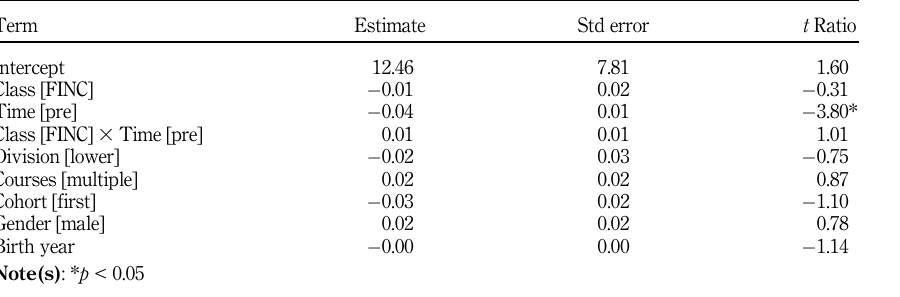
Table 7. Repeated measures model for average